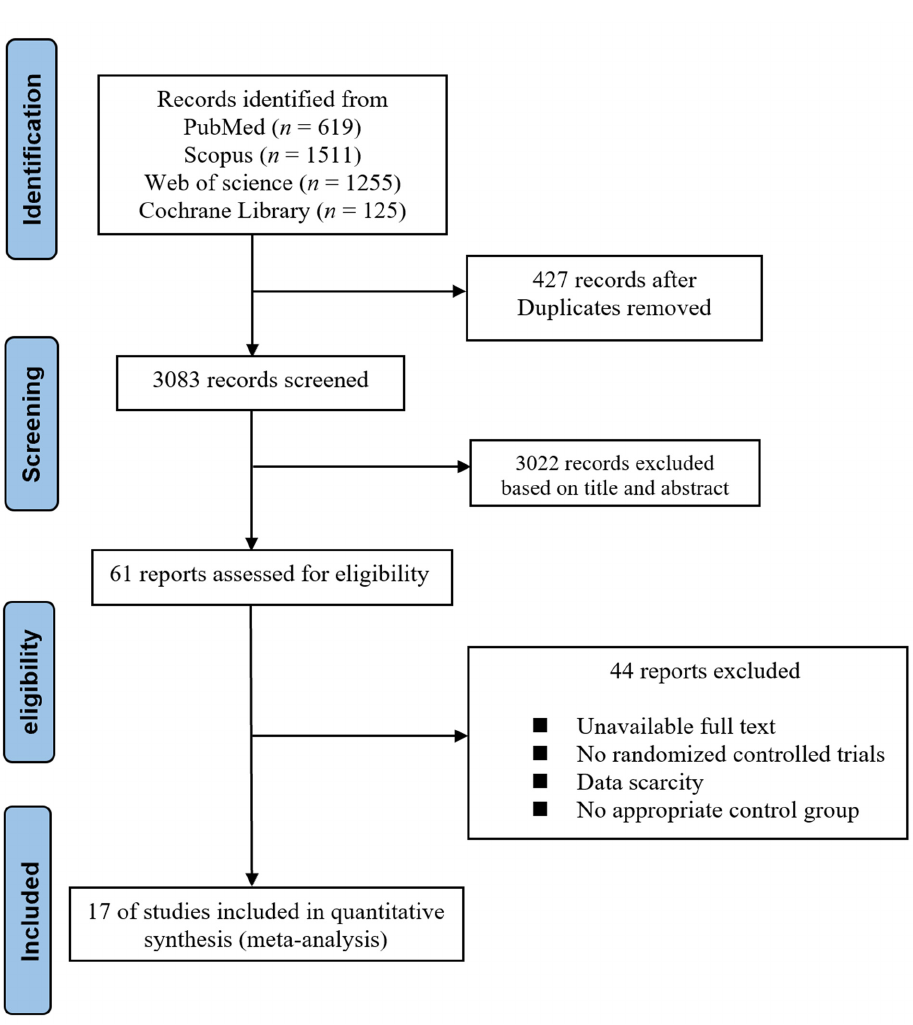
Figure 1. PRISMA flow chart of selected trials.